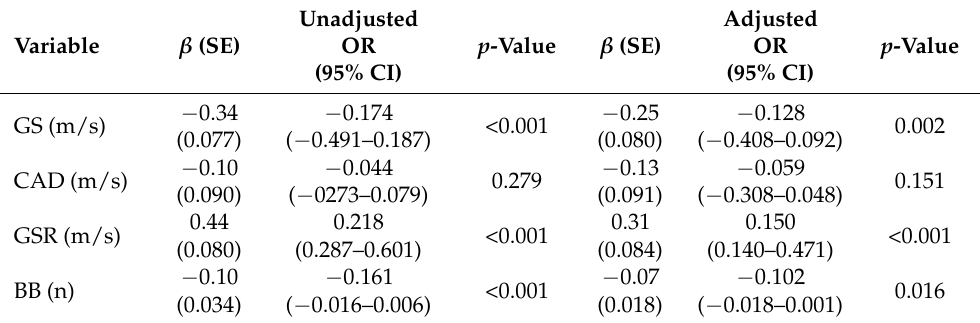
Table 3. Associations between gait speed, cadence, gait stability ratio, body balance versus falls, results expressed by logistic regressions.